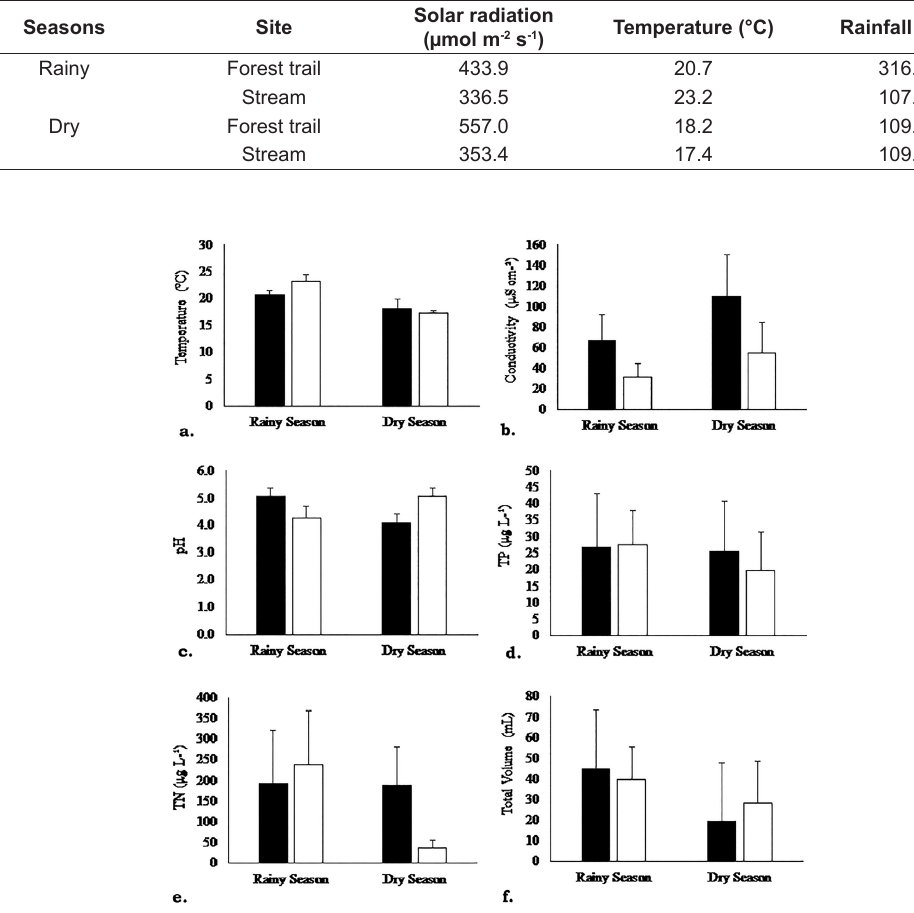
Table 1. Medium values (n = 8) and standard deviation of climatic variables in the study area. The values of rainfall refer to